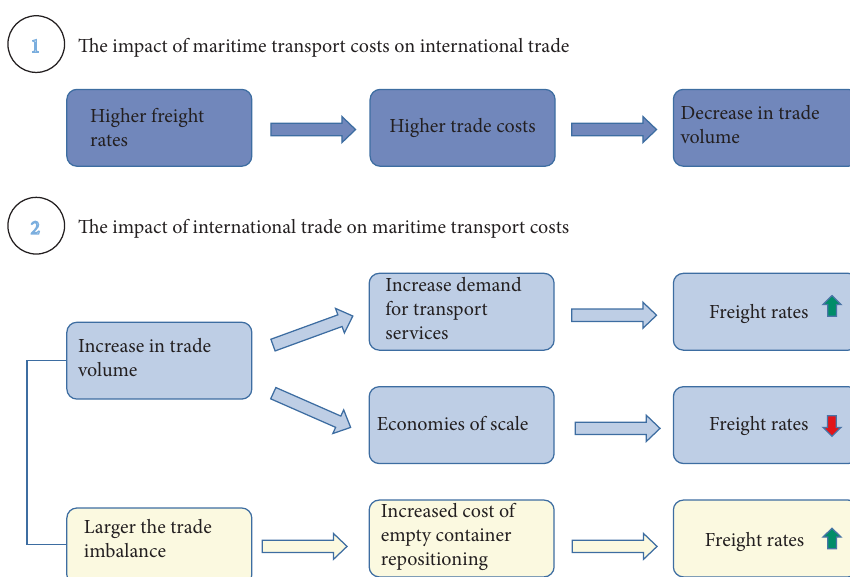
Figure 1: The possible mechanisms of influence between international trade and maritime transport